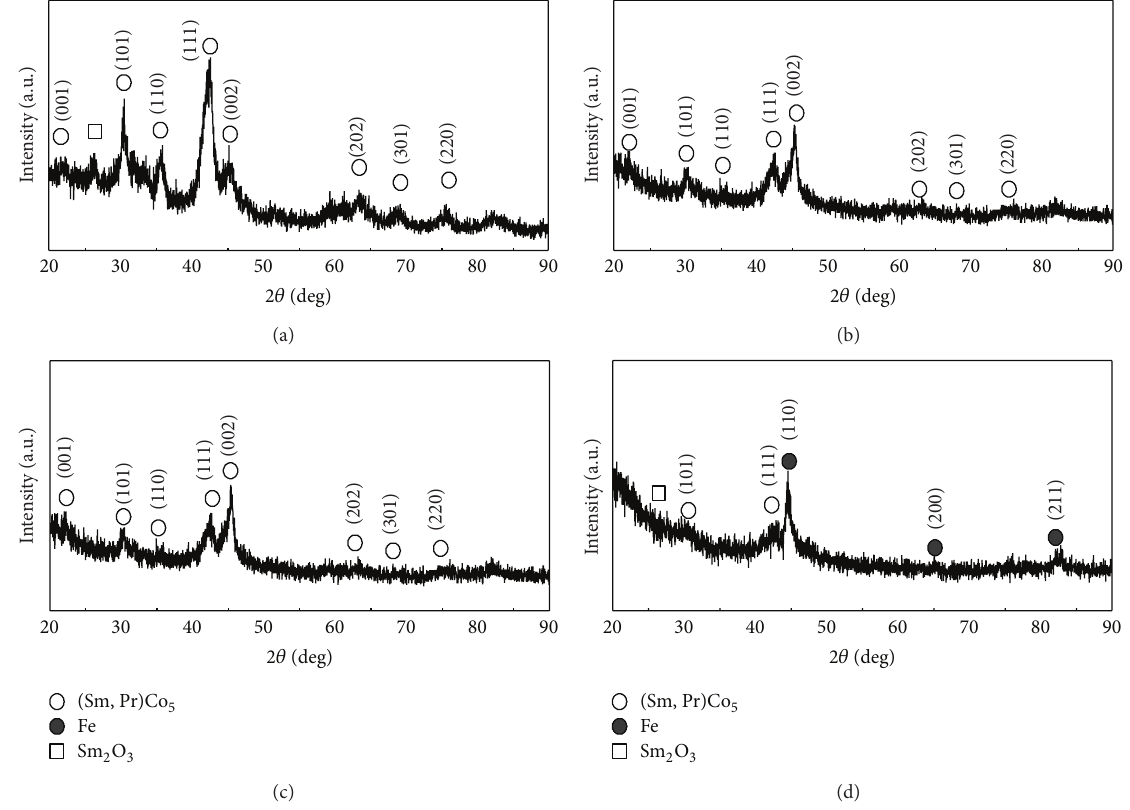
Figure 2: XRD patterns of (Sm,Pr)Co 5 nanoflakes: (a) nonaligned; (b) magnetically aligned; (c) (Sm,Pr)Co 5 /Fe nanocomposites magnetically aligned; (d) (Sm,Pr)Co 5 /Fe nanocomposites annealed at 450 ∘ C.